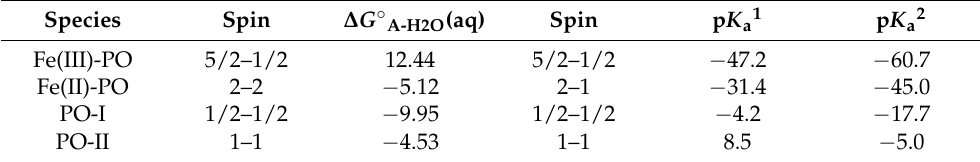
Species Spin ∆ G ◦ A-H2O